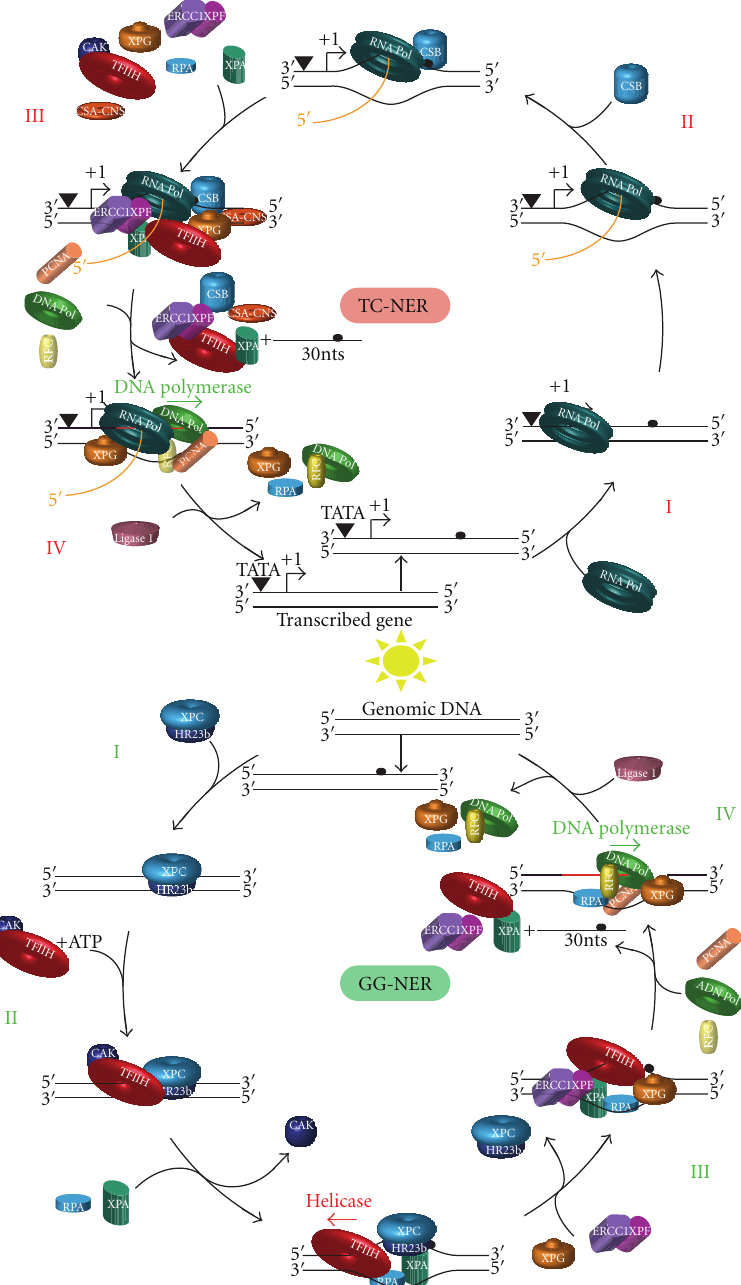
Figure 2: The two subpathways of mammalian NER. Physical or chemical agents like UV, cis-platin, or benzopyrene can damage DNA and induce damage-mediated helix distortions anywhere in the genome (GG-NER in green, bottom panel) or on the transcribed strand of a gene (TC-NER in red, top panel). Bottom panel: (I) XPC-RAD23B recognizes and binds to DNA damage-mediated helix distortion to initiate GG-NER. (II) TFIIH is recruited in an ATP-dependent manner, followed by XPA and RPA, which verify the presence of the lesion. During this step, the CAK module of TFIIH is released from the preincision complex [29]. (III) Within the preincision complex, ERCC1-XPF and XPG structure-specific endonucleases incise the damaged strand on the 5 (cid:2) and 3 (cid:2) sides of the lesion, respectively. Following incision, NER factors are released from the DNA, except XPG and RPA that favour the recruitment of the replication machinery composed of PCNA, RFC, and the DNA Polymerases δ , ε , or κ (ref). (IV) Following replication of the gap, the DNA is sealed by the ligase 1 (or the ligase III-XRCC1 complex in nondividing cells). Top Panel: (I) TC-NER is triggered by DNA damage-mediated blockage of RNA-Pol II (Top panel). (II) CSB is then recruited to the stalled RNA-Pol II enzyme and triggers the recruitment of the NER factors TFIIH, XPA, RPA, ERCC1-XPF, and XPG together with the CSA-CNS complex (III). (IV) Following the excision of the damaged oligonucleotide, the same DNA replication machinery of the GG-NER subpathway fills the gap created by the incision/excision